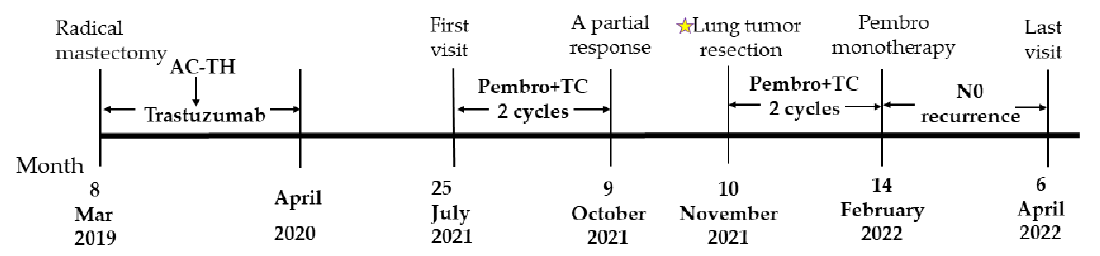
Figure 5. A patient treatment